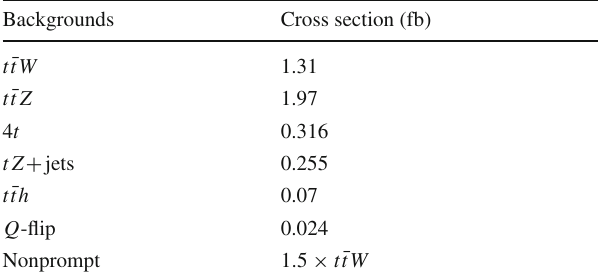
Table 3 The background cross sections after selection cuts for the same-sign top search. The backgrounds cross sections are all normal- ized to either NLO or NNLO as in Ref. [122] Backgrounds Cross section